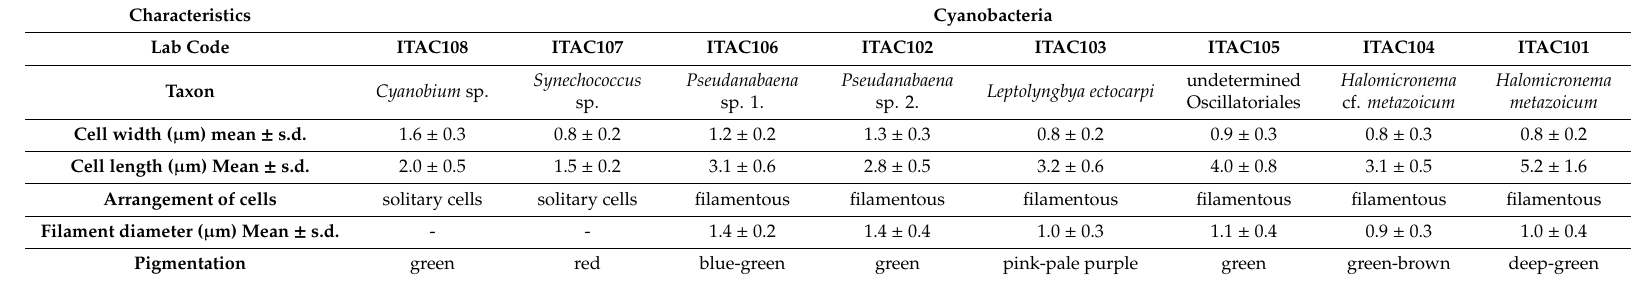
Table 1. Morphological features of the cyanobacterial strains isolated from Petrosia ficiformis and observed with light